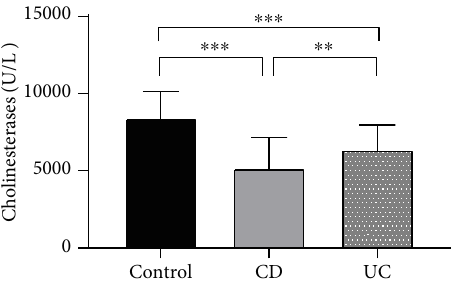
Figure 1: Serum ChE levels in CD patients, UC patients, and healthy controls. ∗∗ P < 0 : 01 ; ∗∗∗ P < 0 : 001 .